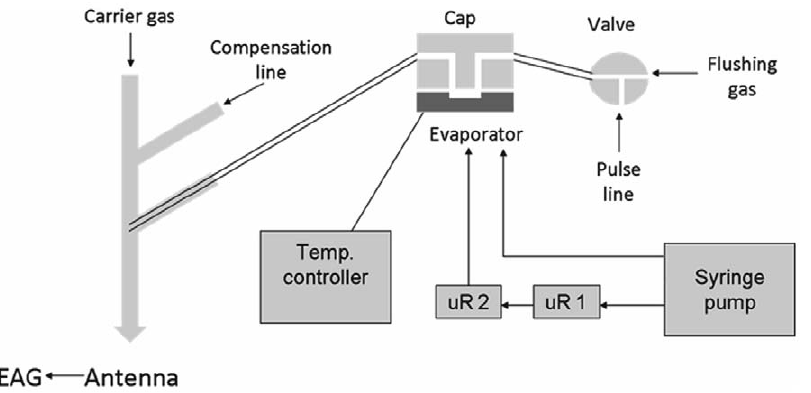
Figure 5. Schematic representation for the integration of two microreactors (uR1, uR2), evaporator and EAG detection.